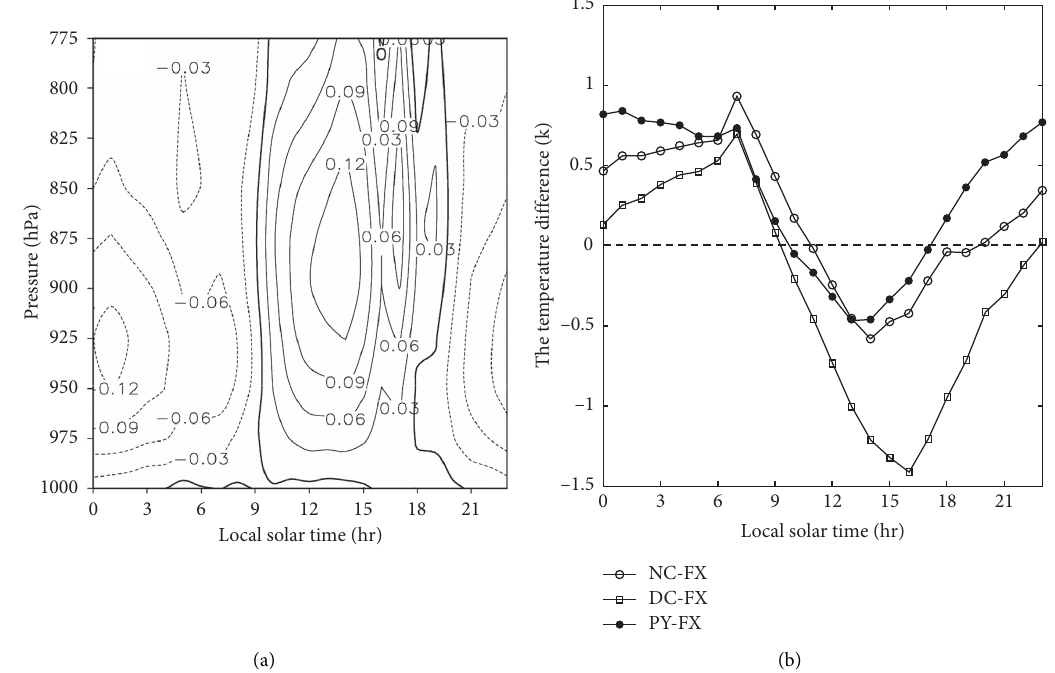
Figure 9: (a) The time-height variation of mean omega (lines, Pa s − 1 ) over PL (i.e., the grids of 116.25 ° E, 29 ° N, and the thick lines represent the zero-velocity lines). (b) The diurnal variations of 2 m air temperature differences between Nanchang (NC), Duchang (DC), Poyang (PY), and Fengxin